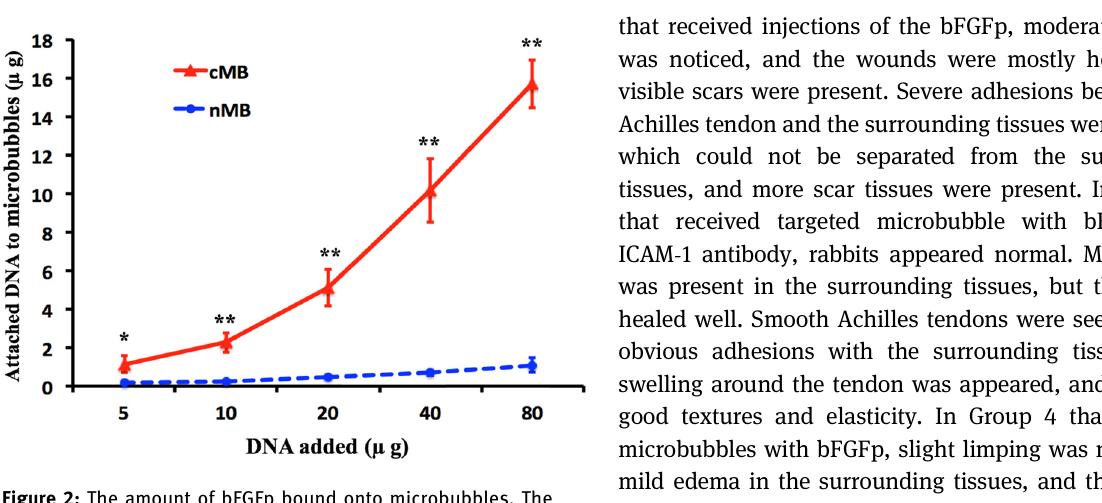
Figure 2: The amount of bFGFp bound onto microbubbles. The relationship between the binding rate and bFGF DNA concentration.